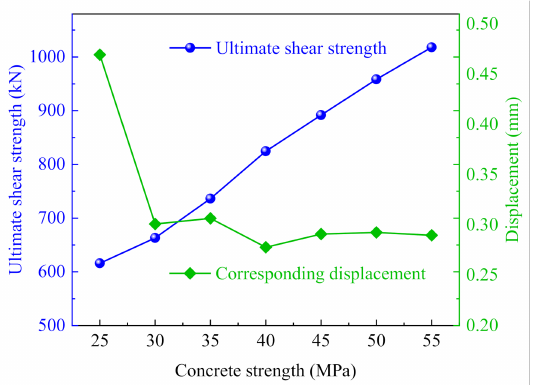
Figure 12. Ultimate shear strength and the corresponding displacement of S-SWJ with different concrete strength.